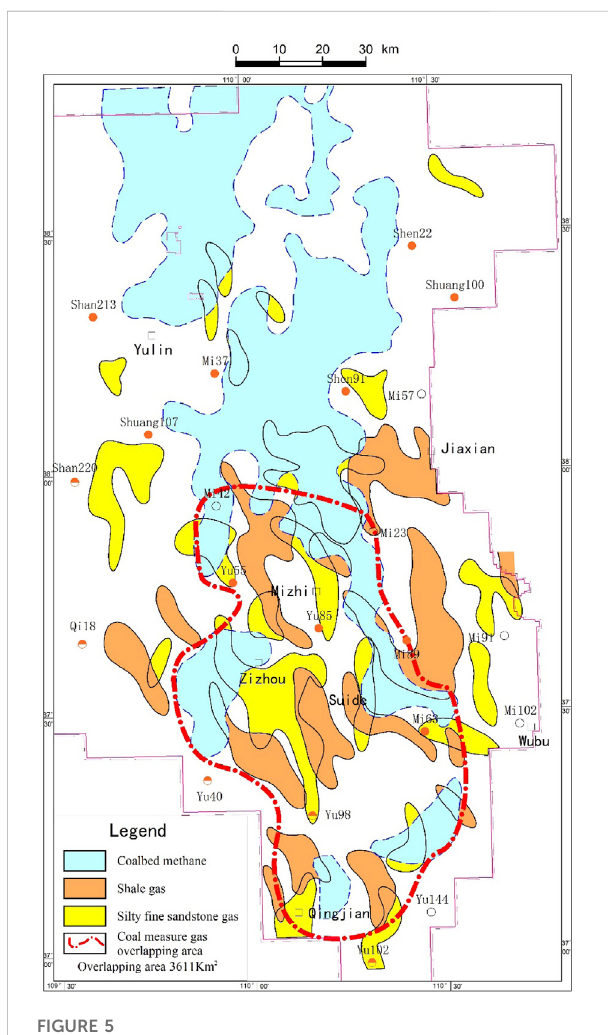
FIGURE 5 Favorable zone of coal measure gas distribution of Shan 2 in eastern Ordos